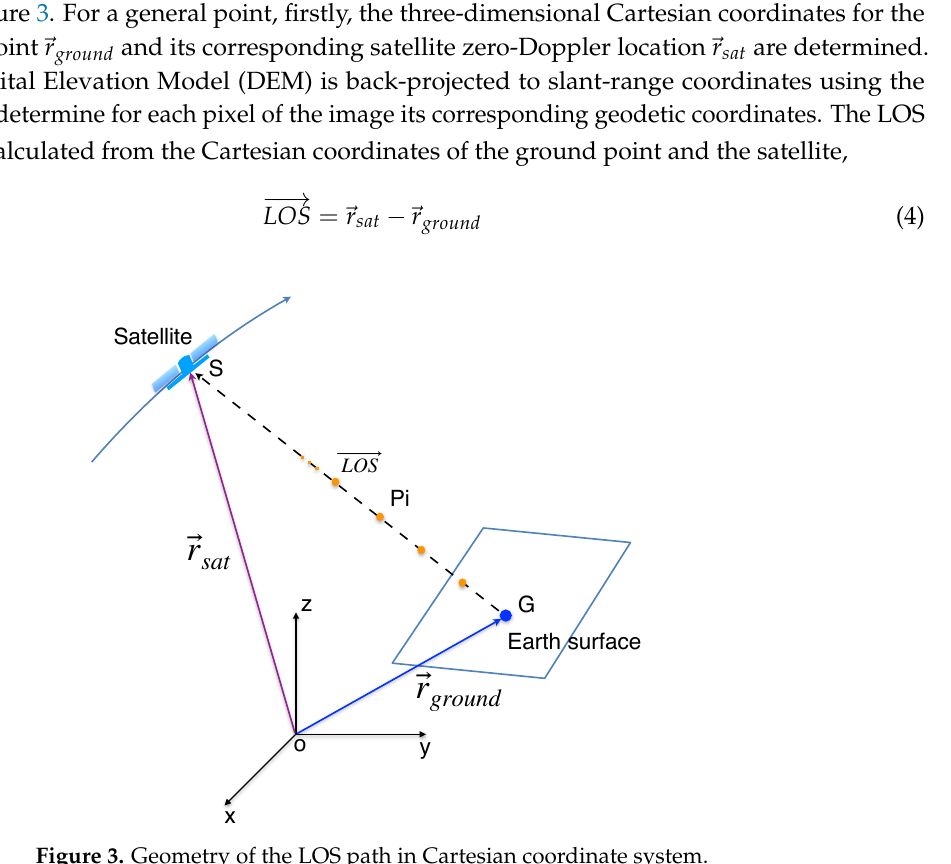
Figure 3. Geometry of the LOS path in Cartesian coordinate